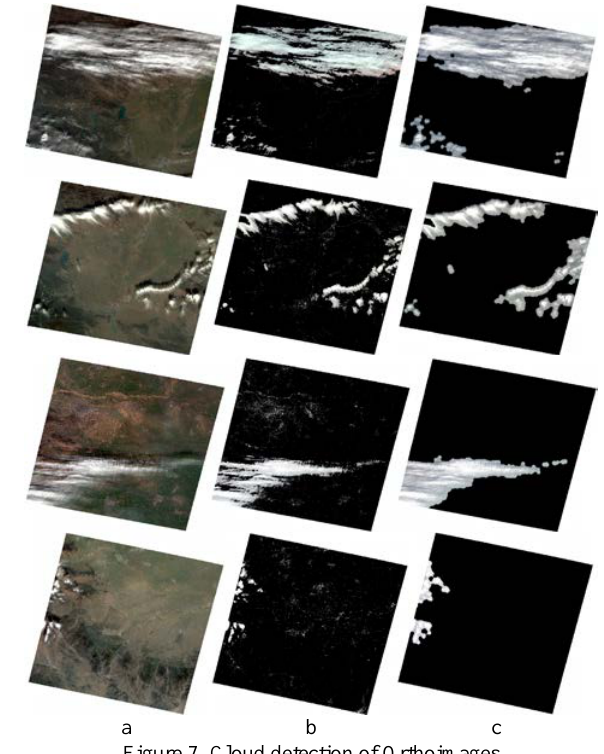
Figure 7. Cloud detection of